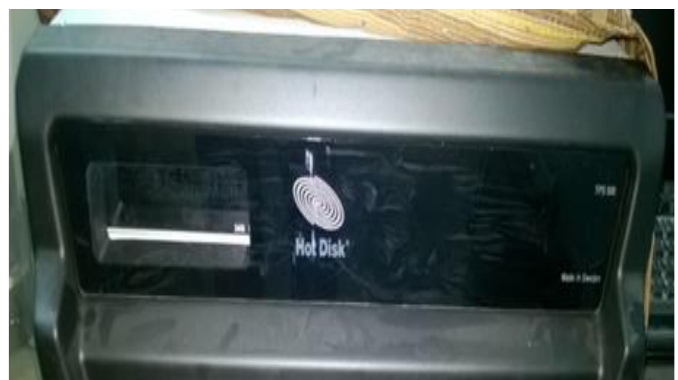
Figure 3. Hot disk thermal constants analyser.